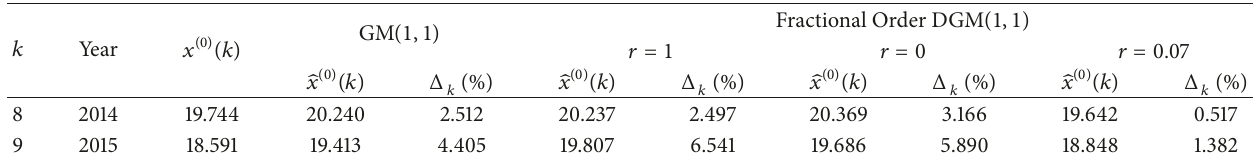
Table 6: Model testing result of China’s sulfur dioxide emissions (unit: million